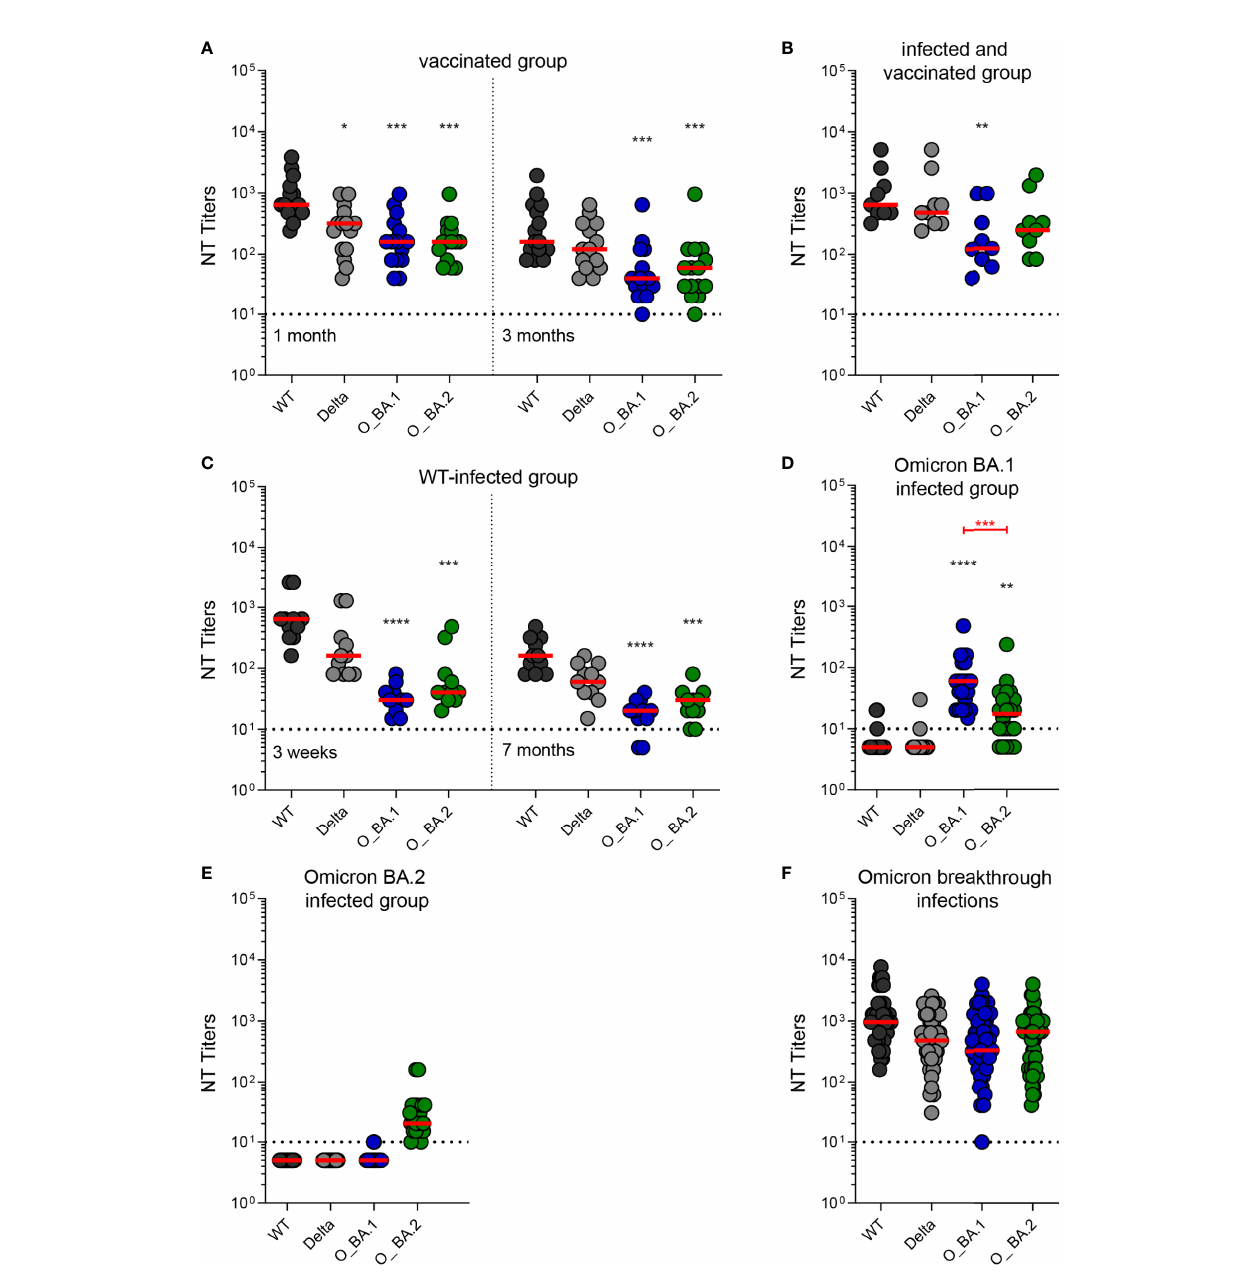
FIGURE 1 | Neutralizing antibody titers against an ancestral wildtype (WT) strain and three variants of concern (Delta, Omicron BA.1, and Omicron BA.2) in post- vaccination and post-infection serum samples. (A) Serum samples from individuals who had received three doses of an mRNA vaccine collected one month and three months after the last vaccination (n=15). (B) Serum samples from individuals who were infected with a WT strain, followed by three doses of an mRNA vaccine collected three weeks after the last vaccination (n=9). (C) Serum samples from individuals who were infected with a WT strain collected three weeks and seven months after infection (n=11). (D) Serum samples obtained from individuals who had a primary infection with Omicron BA.1 collected one month after infection (n=22). (E) Serum samples obtained from individuals who had a primary infection with Omicron BA.2 collected one month after infection (n=21). (F) Serum samples from individuals who were infected with an Omicron variant and had previously been vaccinated collected one month after infection (Omicron breakthrough infections, n=43). Horizontal dotted lines show the cut-off, dots individual sera, and red lines median titers. Black asterisks indicate signi fi cant differences to WT (D614G). The Kruskal-Wallis test with Dunn ’ s post-hoc test was used for signi fi cance testing (*, p < 0.05; **, p < 0.01; ***, p <0.001; ****, p < 0.0001). Signi fi cant differences between Omicron BA.1 and BA.2 neutralization titers are indicated by red asterisks (Mann-Whitney test; ***, p < 0.001). WT, wildtype strain (B.1.1) with the D614G substitution; Delta, Delta VOC (B.1.617.2-like, sub-lineage AY.122); O_BA.1, Omicron (B.1.1.529) sub-lineage BA.1 VOC; O_BA.2, Omicron sub-lineage BA.2 VOC; NT, neutralization